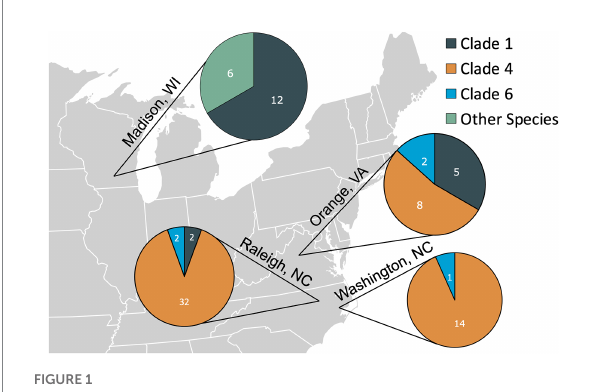
FIGURE 1 The number of fleas from each location assigned to the Ctenocephalides felis clades defined by Lawrence et al. (2019) or belonging to other flea species (Cediopsylla simplex , Orchopeas howardi , and Nosopsylus fasciatus) .